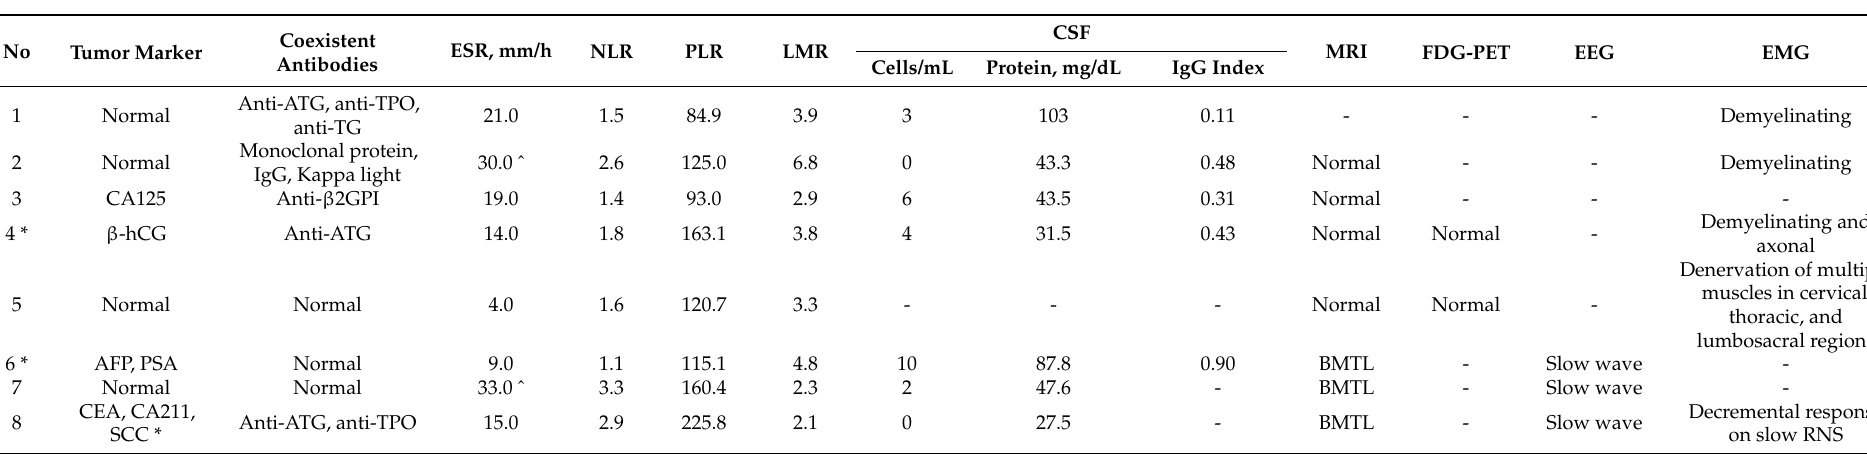
Table 2. Laboratory, electrophysiology, and imaging data of eight patients with antibody-associated paraneoplastic neurologic syndromes at the first attack.